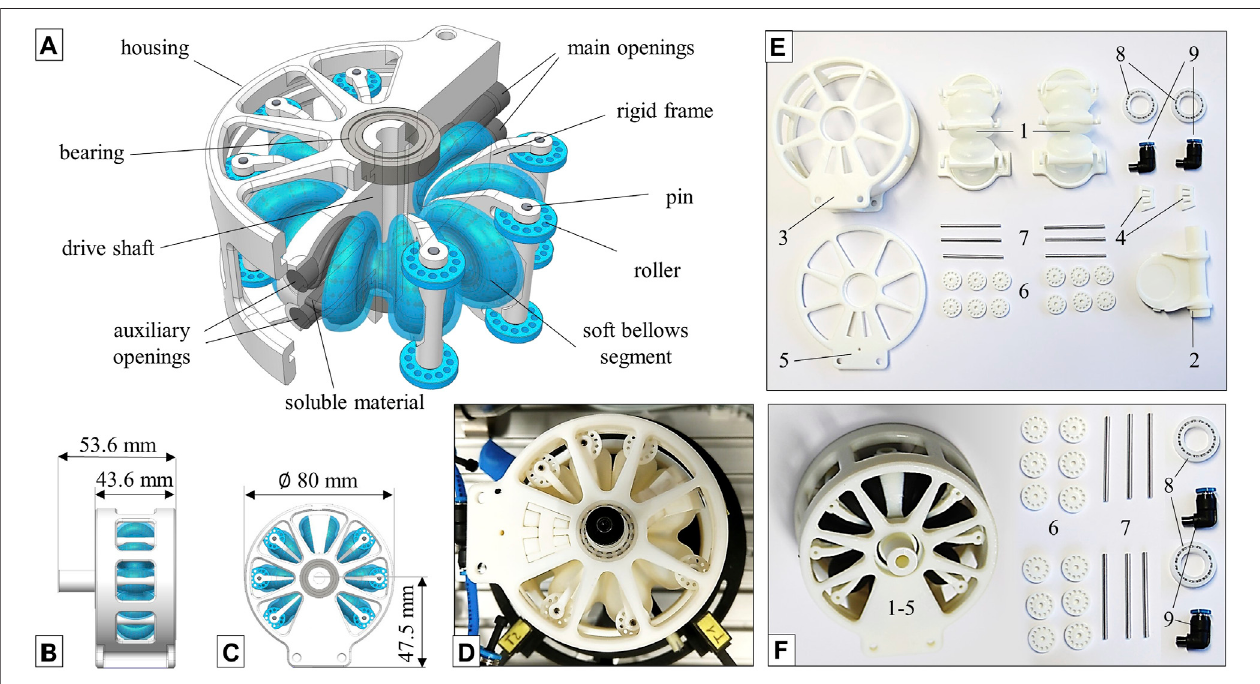
FIGURE 3 | Novel rotary bellows actuator design for multi-material AM with soft bellows segments and rigid features. Components and design features are identi fi ed in the sectional CAD view (A) , and the actuator ’ s main dimensions are given in (B,C) . Applying a pressure difference between the bellows chambers results in angular motion of the actuator which is guided by a roller system (D) . A “ partly integrated ” variant (E) consists of nine different components, each of which can be replaced individually. In a “ highly integrated ” variant (F) , the actuator ’ s main components (1 – 5)are integratedinto asingle multi-material part tominimize assembly.